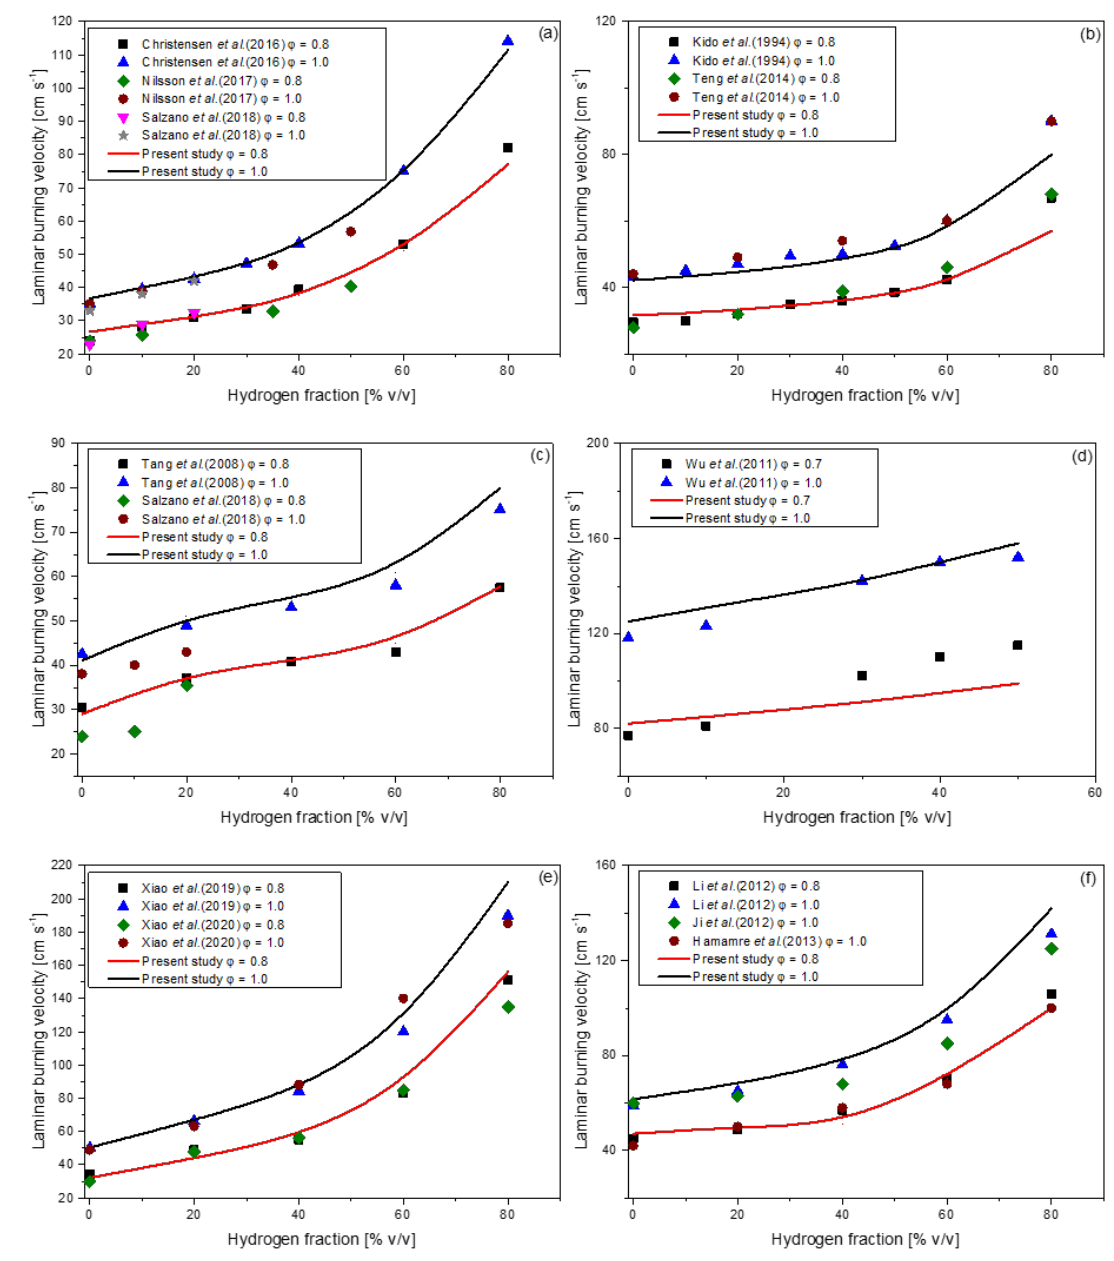
Figure 2. Effect of hydrogen fraction on laminar burning velocity of methane ( a ) [9,11], ethane ( b ) [58,59], propane ( c ) [9,13], acetylene ( d ) [20,44], methanol ( e ) [30,32], and ethanol ( f ) [7] for lean and stoichiometric mixtures with air.